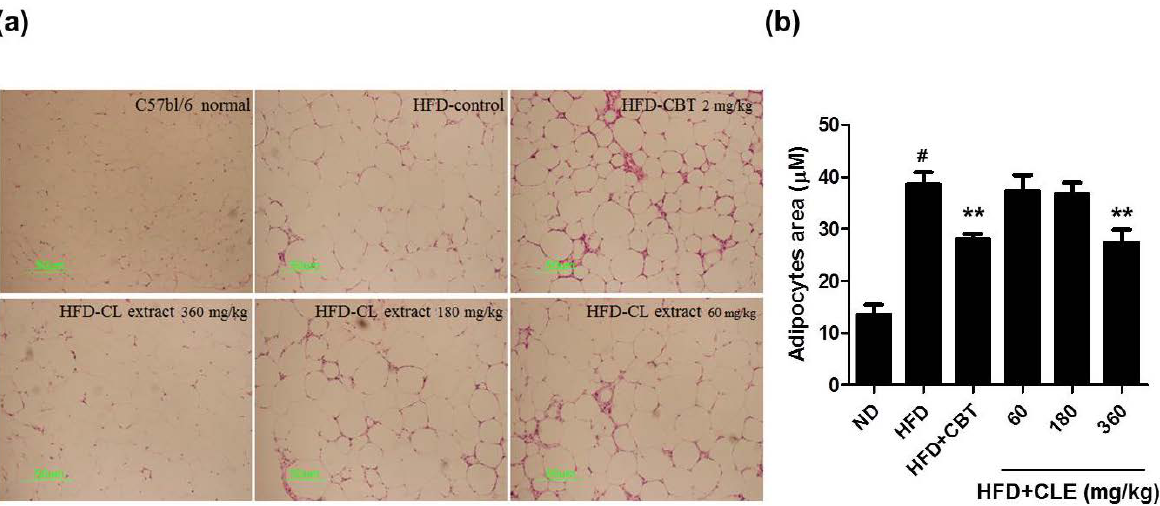
Figure 3. Effect of CLE on adipocyte area in adipose tissue of mice fed a HFD. ( a ) Representative sections of adipose tissue in different groups. Lipid accumulation was visualized using Oil Red O staining. ( b ) Morphometric analysis of adipose tissue was performed using MetaMorph. Adipocyte area was quantified for each genotype and values represent mean ± SEM ( n = 10), # p < 0.05 vs. ND-fed mice, ** p < 0.01 vs. HFD-fed mice. ND: normal chow diet, HFD: 60% high fat diet + vehicle, HFD + CBT: 60% high fat diet + reductil (CBT, 2 mg/kg), HFD+CLE: 60% high fat diet + CLE (60, 180 and 360 mg/kg,